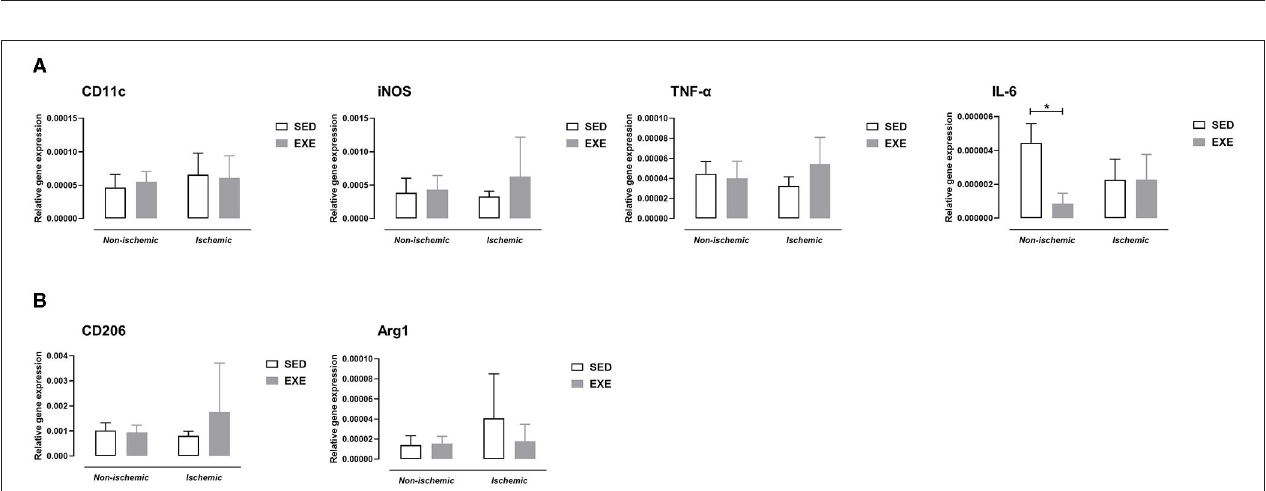
FIGURE 6 | Effect of preventive exercise on hindlimb muscle inflammation of ApoE − / − mice 5 weeks after PAD. Gene expression analysis by real-time RT-PCR of pro-inflammatory M1 macrophage markers and cytokines (A) , and of anti-inflammatory M2 macrophage markers (B) in non-ischemic and ischemic gastrocnemius muscles of SED and EXE mice ( n = 4-6 animals per group). Two-way ANOVA with Sidak’s multiple comparisons test in (A,B) : * p < 0.05 versus SED. Bar graphs represent mean ±